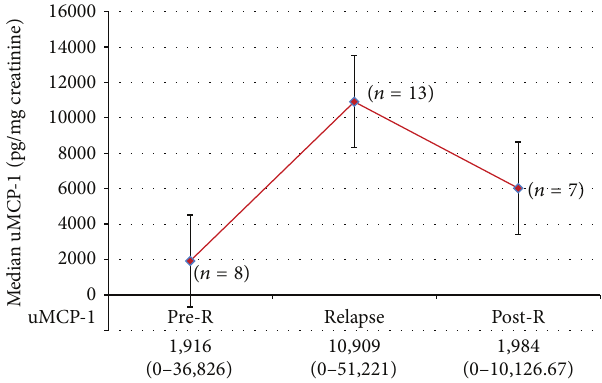
Figure 1: Median uMCP-1 levels in LN relapse compared to pre- and postrelapse